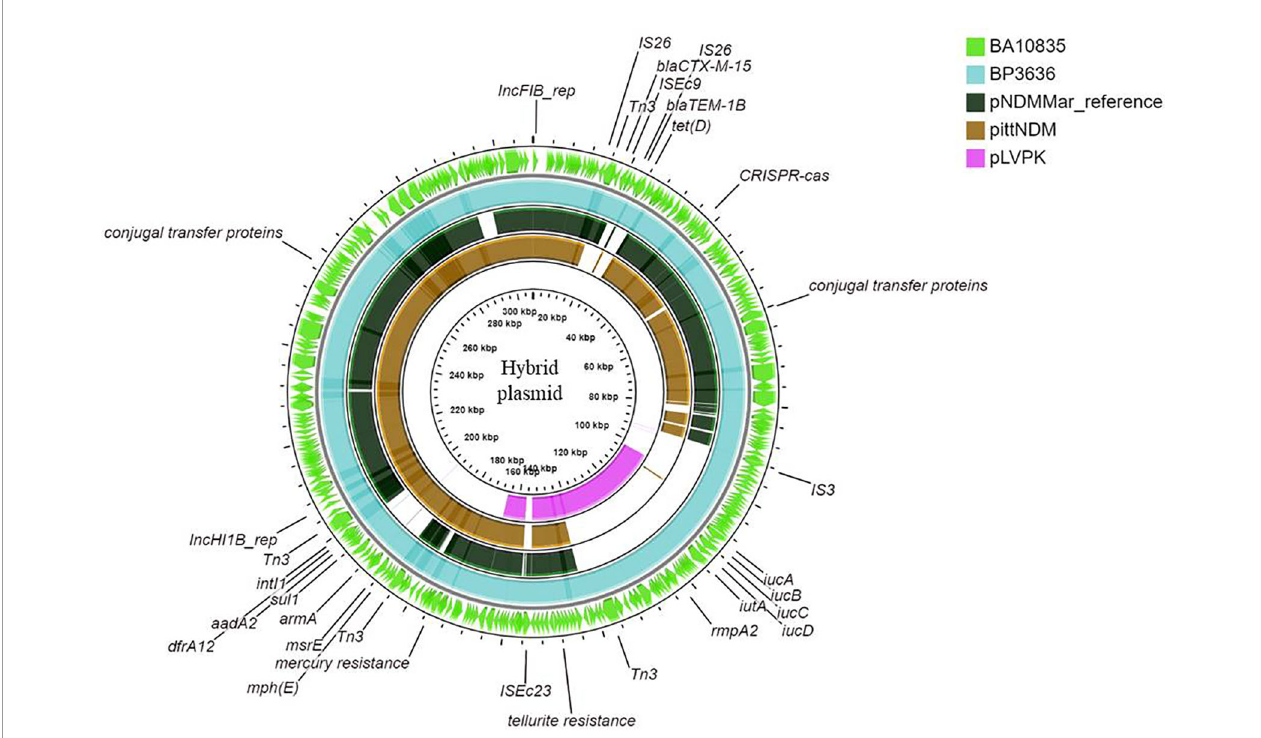
FIGURE 4 | Maps of ST2096 mosaic plasmids in comparison to previously reported reference plasmids. Circular comparison map of plasmids from outer to inner rings — BA10836, BP3636, IncHI1B (pNDM-MAR, JN420336.1), PittNDM (NZ_CP006799.1), and pLVPK (AY378100.1)